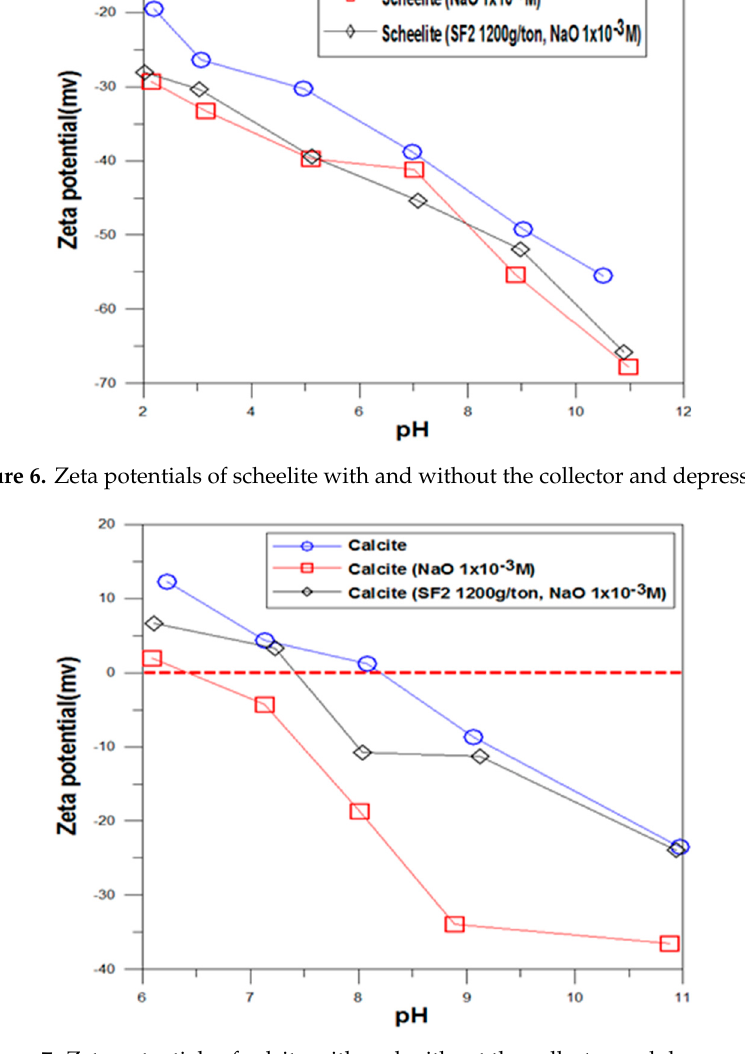
Figure 8. Zeta potentials of fluorite with and without the collector and depressant. As shown in Figures 7 and 8, the zeta potentials of the calcite and fluorite only with the collector are the lowest at each pH compared with the zeta potentials of the minerals with or without the collector and depressant. The zeta potentials of calcite and fluorite with or without the collector and depressant show similar behaviors with increasing pH, which indicates that the addition of the SF2 depressant interfered the adsorption of the collector on the surface of minerals. Therefore, the addition of SF2 could enhance the selectivity of scheelite flotation. FTIR analysis was performed to examine the adsorption of the flotation reagents on the surface of the minerals conditioned at the optimum flotation conditions, and the results were shown in Figures 9–11 for scheelite, calcite, and fluorite, respectively. Figure 9 shows the FTIR analysis results for scheelite, where the spectrum of sodium oleate forms the bands at 1559.1 and 2922.6 cm − 1 . The band at 2922.6 cm − 1 is known to be formed by the stretching vibrations of CH 2 and CH 3 [17], and the band at 1559.1 cm − 1 is caused by the carbonyl mode (C=O), which mainly indicates a physically adsorbed species [7,20,21]. The spectrum of scheelite without flotation reagents (NaO and SF2) shows the bands in the 650–1000 cm − 1 range, and, when the scheelite sample was conditioned in the 1 × 10 − 3 M sodium oleate solution, a band was observed at 2871.3 cm − 1 , which is similar to the 2922.6 cm − 1 of sodium oleate. In the experiment where the SF2 depressant was added before sodium oleate, a band was formed at 2900.7 cm − 1 . These results suggest that the chemisorption of sodium oleate on the scheelite is maintained regardless of the addition of SF2. However, in the cases of calcite and fluorite,